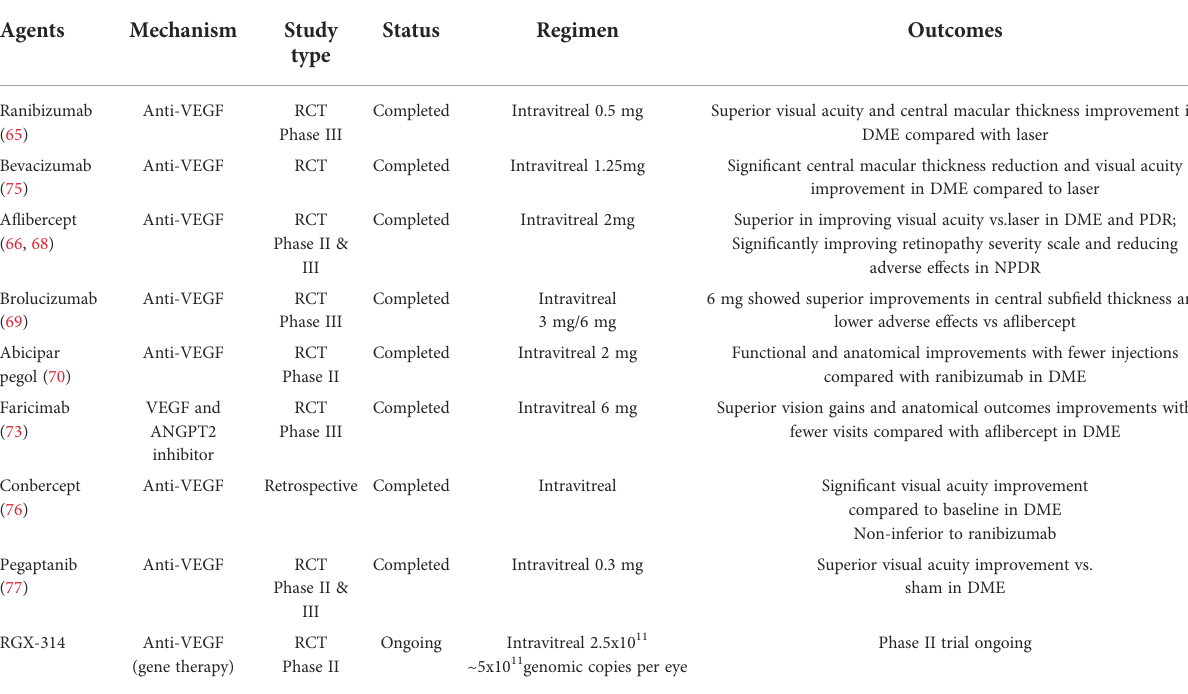
TABLE 2 Anti-VEGF agents for treatment of